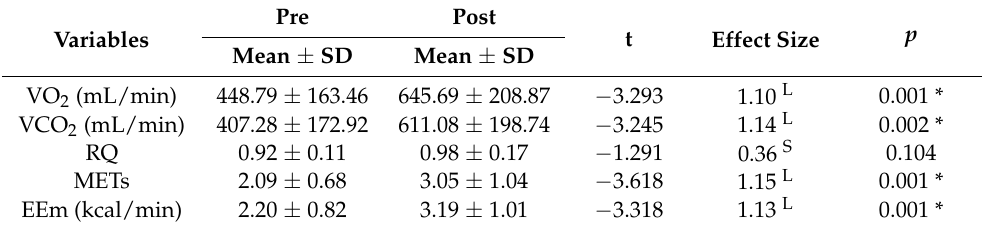
Table 4. Changes in respiratory gas variables pre- and